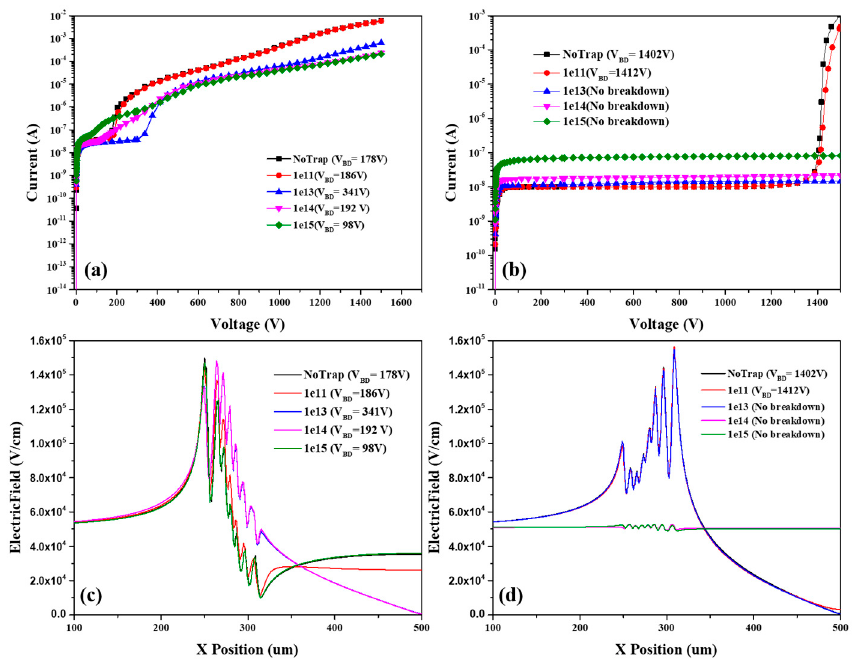
Figure 11. The post − irradiation performance simulation results of the I–V curve for the ( a ) c − SSBD and ( b ) Hybrid − SSBD device, and the electric field distribution of ( c ) c − SSBD and ( d ) Hybrid − SSBD.